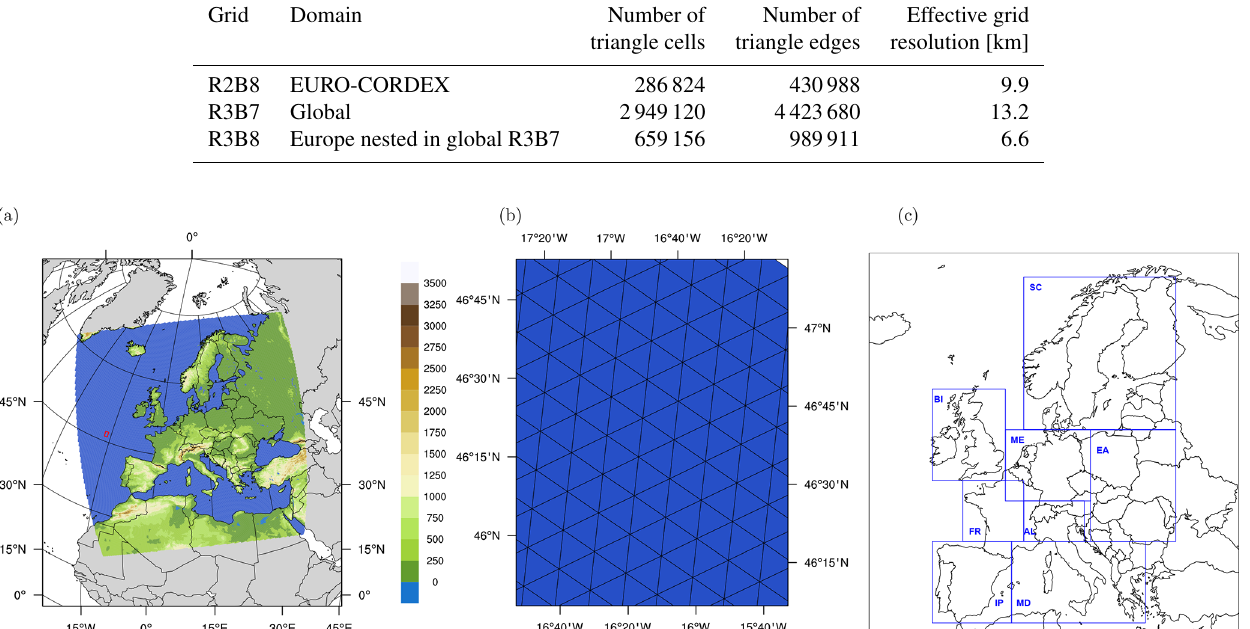
Figure 2. (a) Simulation domain (EURO-CORDEX) and model orography [m] of ICLM-REF on the R2B8 grid. (b) Illustration of the icosahedral grid of ICON-CLM at the R2B8 resolution from a closer look at the red-marked region from panel (a) . (c) Evaluation was done for the eight PRUDENCE subregions (BI: British Isles, IP: Iberian Peninsula, FR: France, ME: Mid-Europe, SC: Scandinavia, AL: Alps, MD: Mediterranean, and EA: Eastern